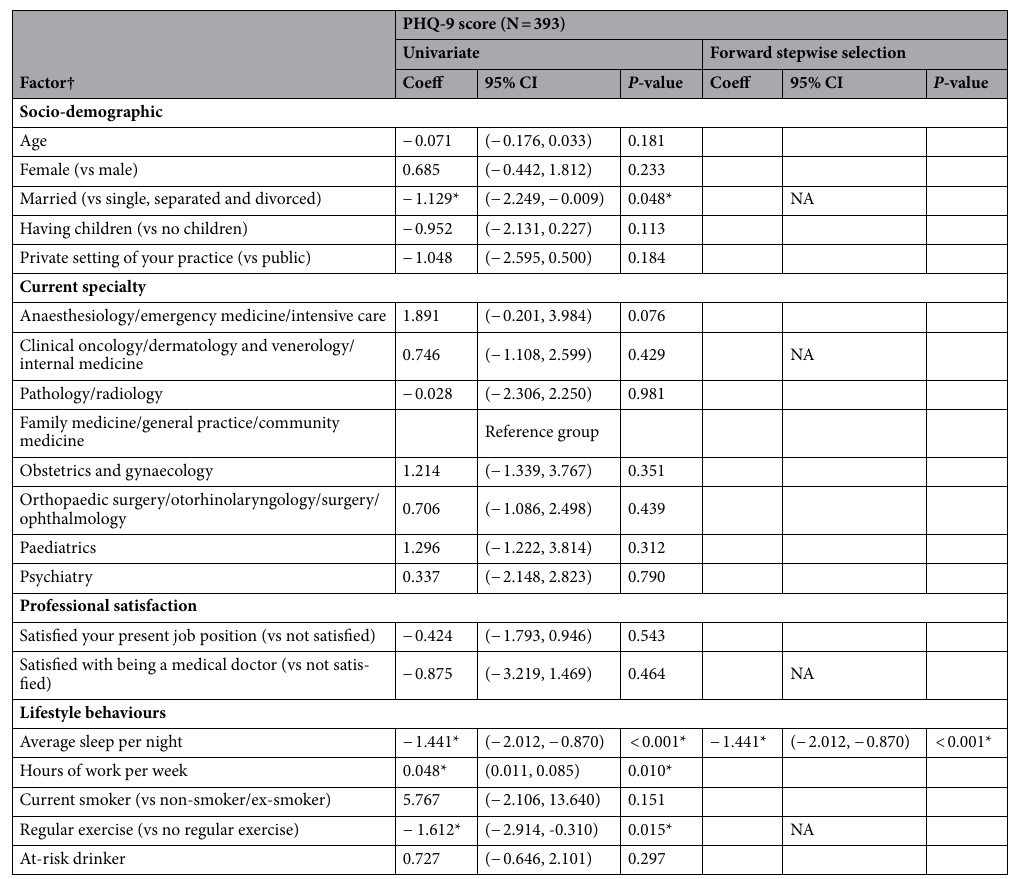
Table 2. Sociodemographic, professional satisfaction and lifestyle behaviour associated with PHQ-9 total score by regression analysis. CI = Confidence Interval; Coeff = Coefficient; NA = Not Applicable. Current Smoker (Current smoker vs Non-smoker/ex-smoker). Regular exercise (5 or more days per week for at least 10 min per day / Any vigorous and moderate physical activities). Private Practice (Private Solo/ Private Hospital/Non-government organisation). Public Practice (University/Government/Hospital Authority/Not applicable). At-risk drinkers were defined if the doctors had 3 or more in AUDIT-C score. * Significant with p -value < 0.05. † Variable in brackets is the reference category for independent